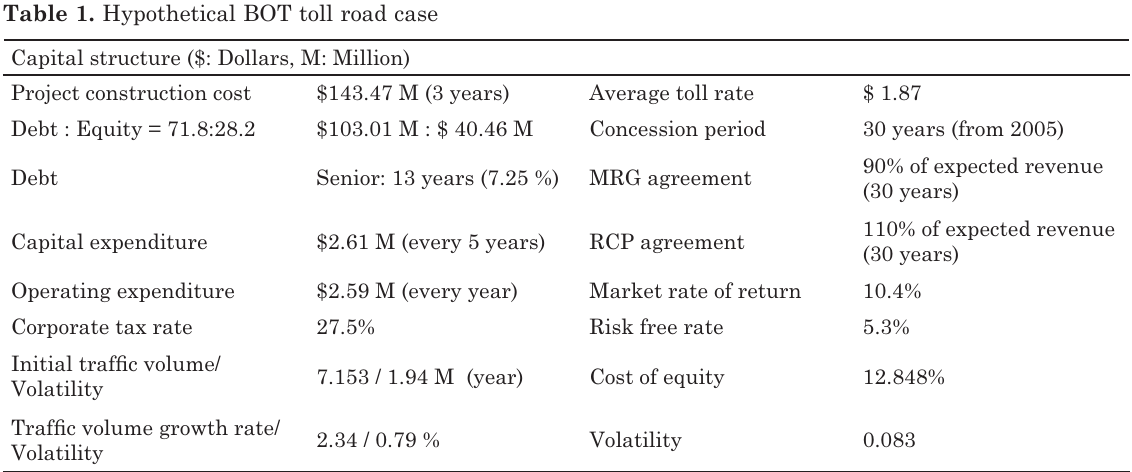
Table 1. Hypothetical BOT toll road case Capital structure ($: Dollars, M: Million)